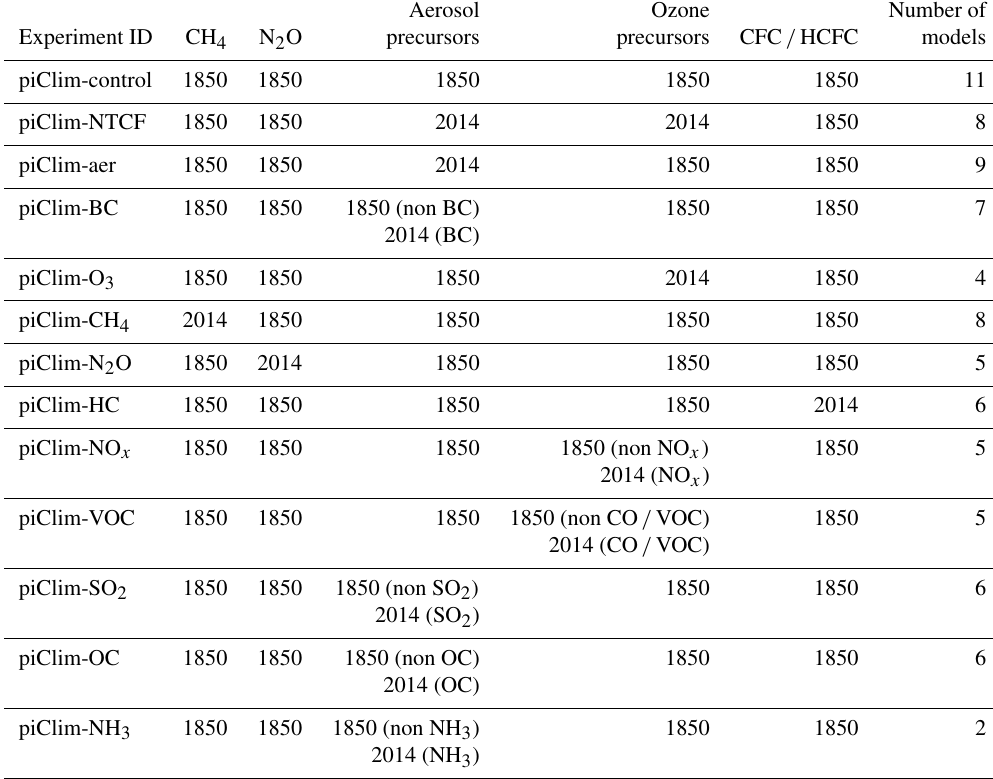
Table 2. List of fixed SST ERF simulations. (“NTCF” as used here excludes methane (Collins et al., 2017). Note that the abbreviation SLCFs (short-lived climate forcers) is used in other publications to refer to near-term climate